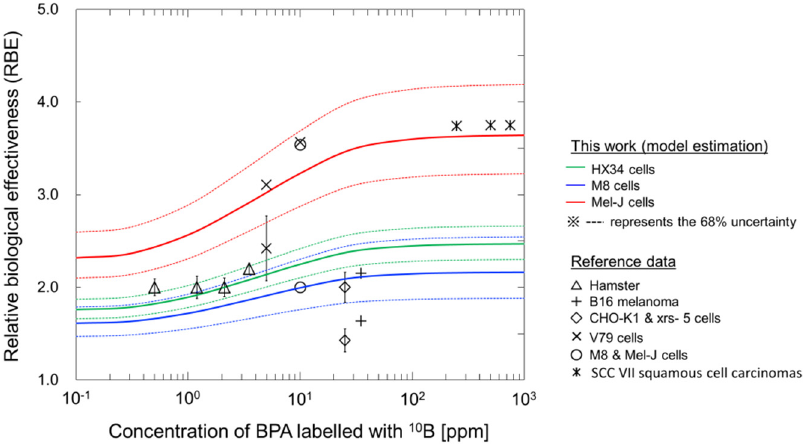
Figure 4. Relationship between 10 B-boronphenylalanine (BPA) concentration and relative biological effectiveness (RBE); solid lines are the estimations from the model, and the symbols are the recommended RBE values reported in the literature [25,26,53–55]. To calculate the RBE values, the y* values for neutron irradiations with any BPA concentration were obtained from the PHITS calculation [28]. The dotted lines represent the 68% uncertainties calculated from the set of model parameters obtained by the MCMC simulation.